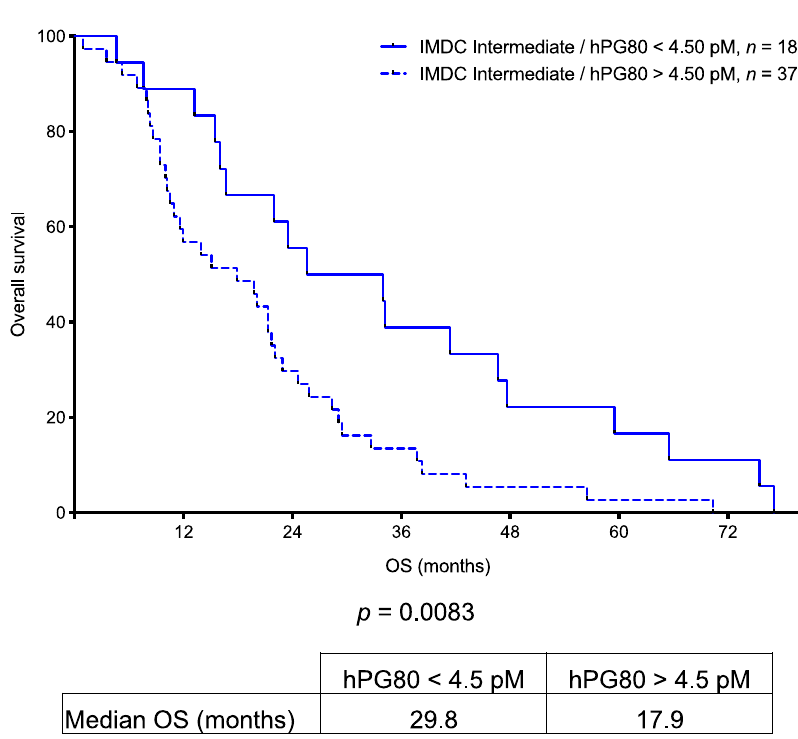
Figure 6. Overall survival in the IMDC intermediate-risk group stratified according to hPG 80 levels. Kaplan-Meier analysis of OS for mRCC patients according to the IMDC risk classification and incorporating hPG 80 levels. Patients in the IMDC intermediate-risk group were divided into two groups based on the calculated cutoff value of hPG 80 (4.5 pM): 18 patients displayed low hPG 80 levels (<4.5 pM) and 37 patients displayed high hPG 80 levels (>4.5 pM). The median OS (in months) and the p values from the log-rank test are indicated.